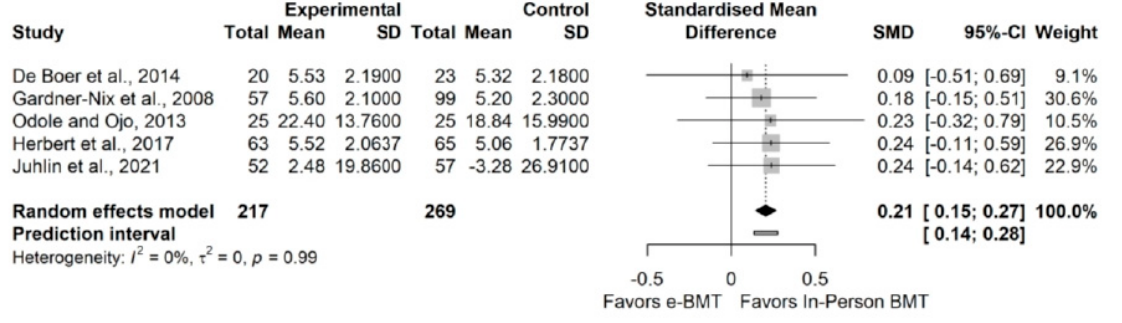
Figure 2. Synthesis forest plot of pain intensity variable of online behavioral techniques against in-person behavioral techniques. The forest plot summarizes the results of included studies (sample size, mean, standard deviation (SD), standardized mean differences (SMDs), and weight). The small boxes with the squares represent the point estimate of the effect size and sample size. The lines on either side of the box represent a 95% confidence interval (CI).